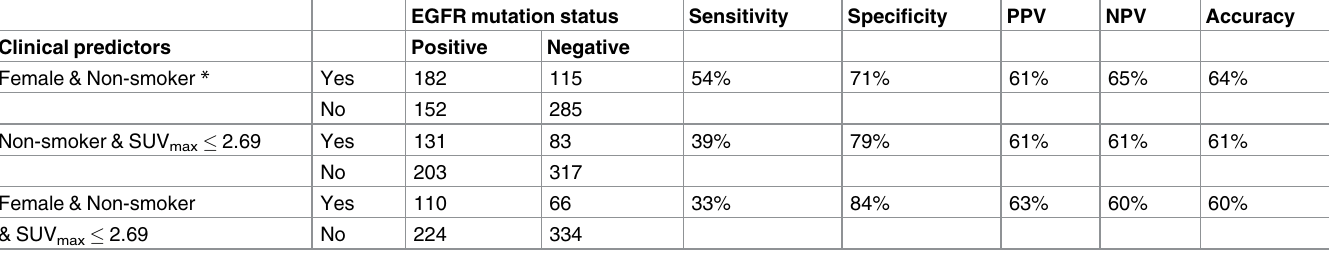
Table 4. Predictability of the EGFR mutation status by the combinations of well-established clinical factors with or without SUV max